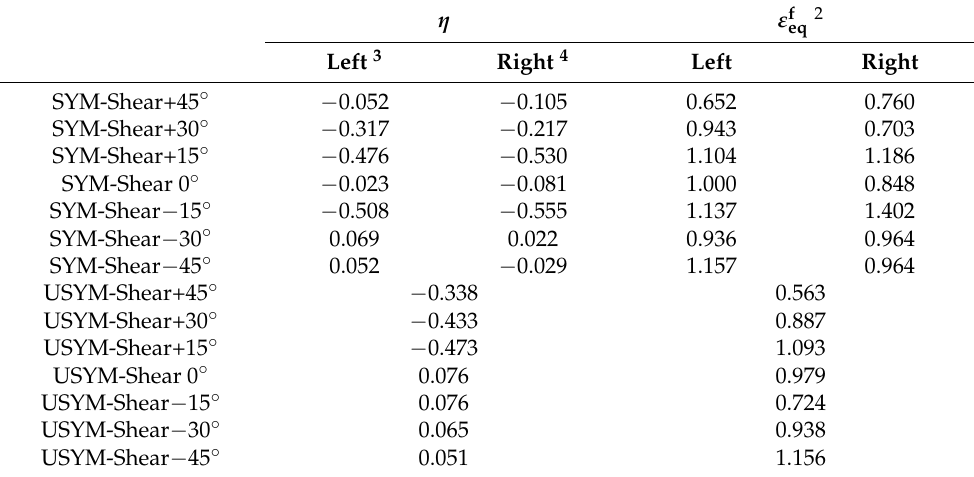
Table 3. Stress triaxiality and equivalent plastic strain obtained from the non-fracture analysis.